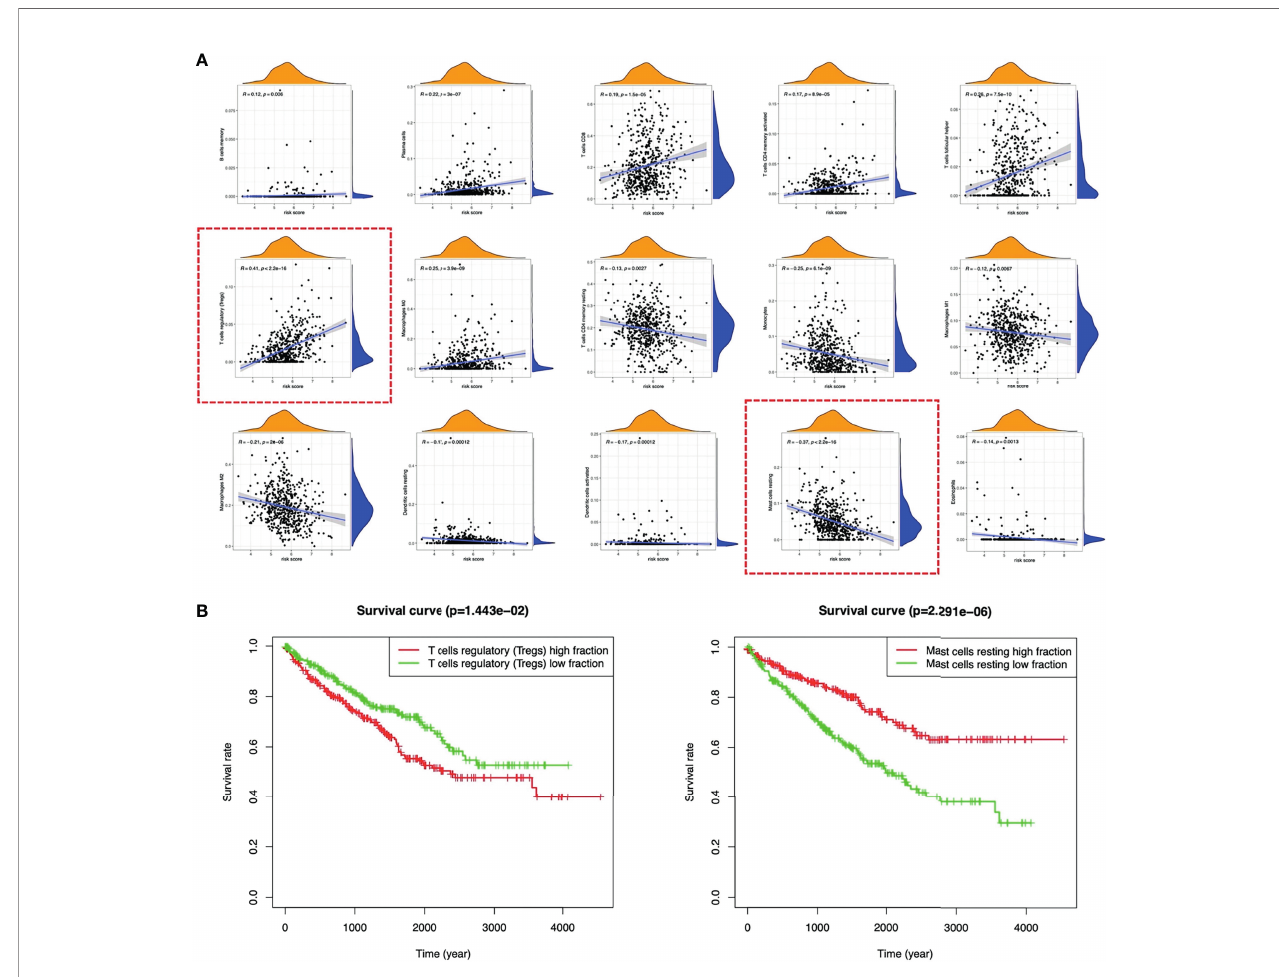
FIGURE 10 | Relationship between TICs and risk score. (A) The correlations between the TICs and risk score. (B) K-M survival curves of Tregs and Mast cells resting in ccRCC. TICs, tumor immune cells; K-M, Kaplan – Meier; ccRCC, clear cell renal cell